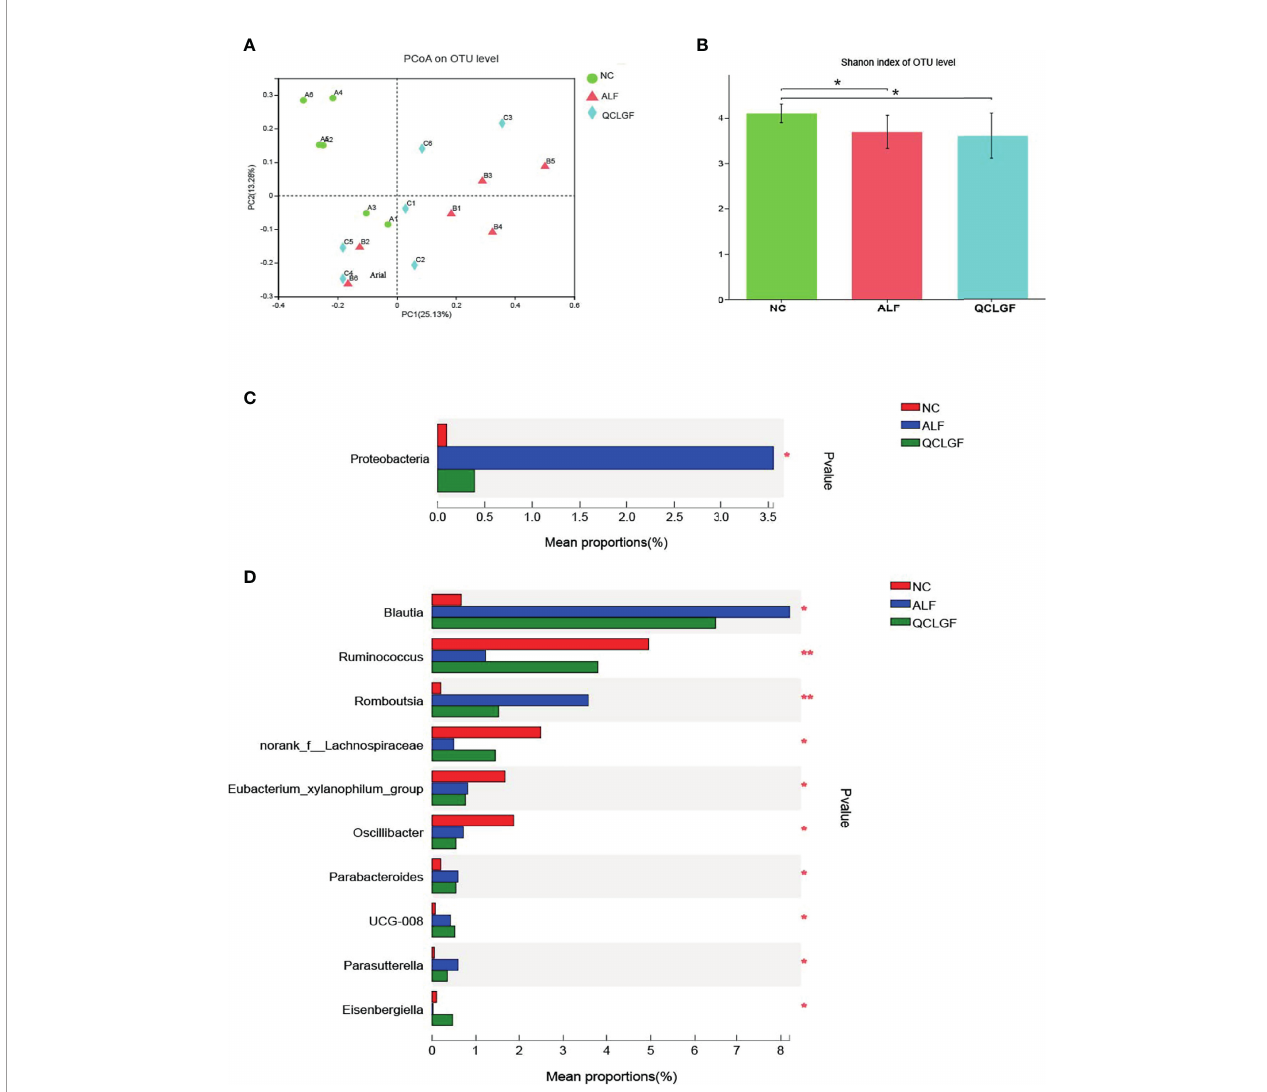
FIGURE 2 | QCLGF protects against D-galactosamine-induced bene fi cial bacterium depletion and pathogen enrichment. (A) Beta diversity was determined by the Bray – Curtis distance-based principal. (B) Shannon index describing the alpha diversity of the microbiota in the three groups, ALF and normal groups (Shannon, P adj = 0.04, t- test), QCLGF and ALF (Shannon, P adj = 0.049, t-test). (C) Alterations in the relative abundances of bacterial taxa at phylum levels in QCLGF, NC, and ALF groups. (* P < 0.05, one-way ANOVA). (D) Alterations in the relative abundances of bacterial taxa at genus levels in QCLGF, NC, and ALF groups. (* P < 0.05 and ** P < 0.01, one-way